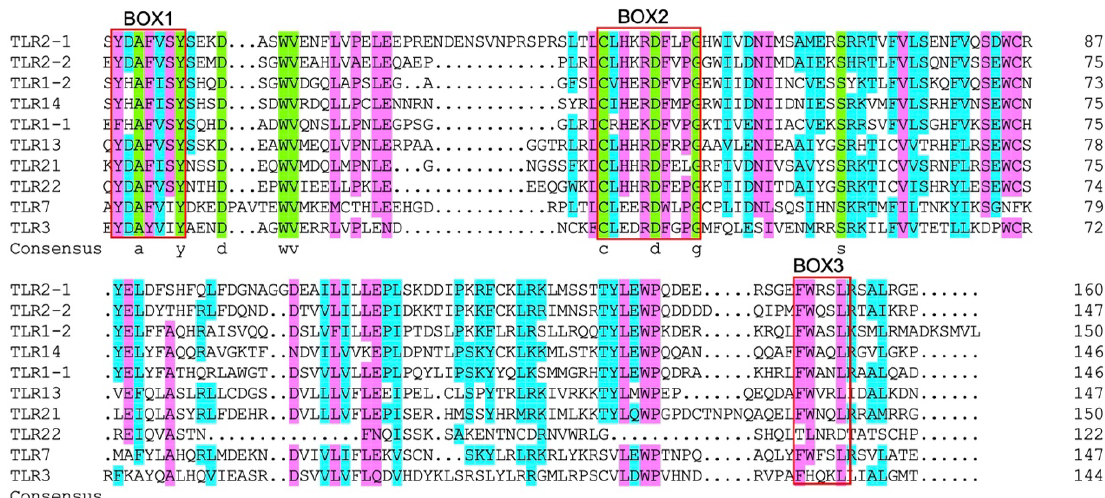
Figure 6. Multiple sequence alignment of the TIR domain in TLRs in marbled rockfish .